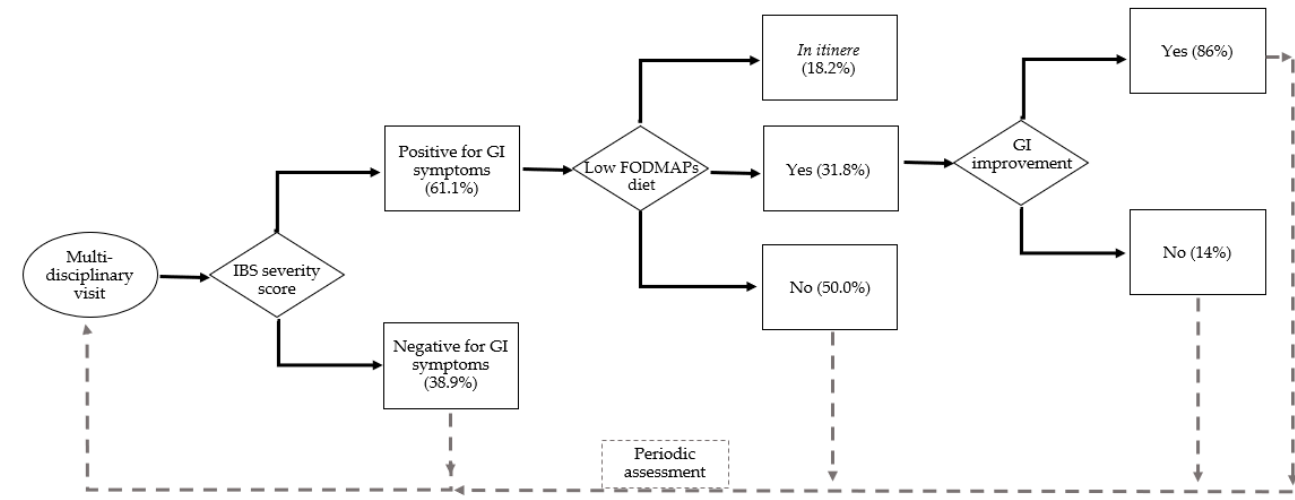
Figure 1. The flowchart of FD patients: first evaluations at the multidisciplinary visit (n. 36) and assessment for GI manifestations by IBS severity score (positive = n. 22), patients that accepted the low-FODMAP protocol (n. 7 completed and n.4 in itinere ).